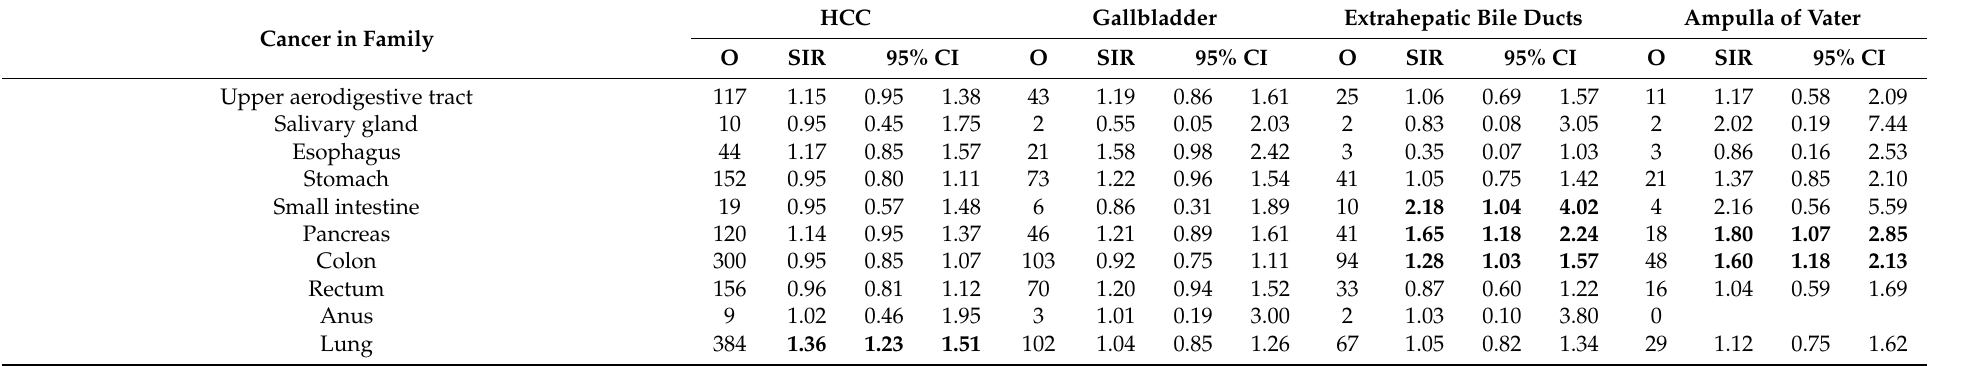
Table 4. Familial risks of hepatobiliary cancer when family members had any